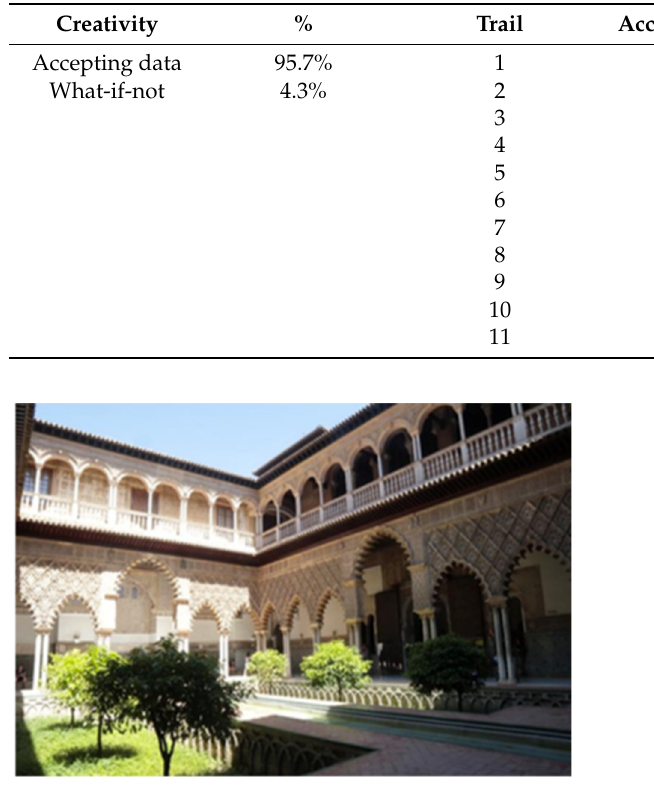
Figure 4. “Consider the patio as a Cartesian plane, as if the X-axis were the short side and Y-axis the long side (each column is a point of the axis). Represent the coordinates (3,3) (0,0) (3,6) (0,4) and (2,7) locating yourselves in the correct point”.